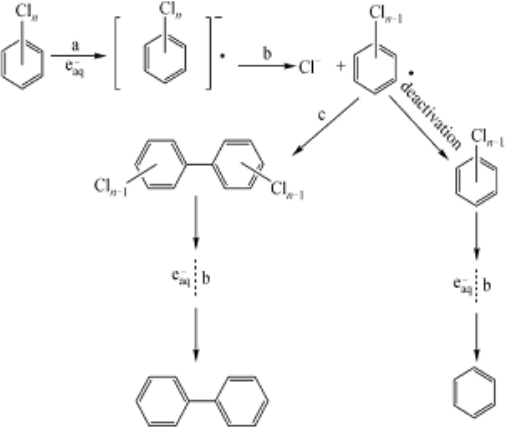
Figure 1. Mechanism of radiation dechlorination of PCBs